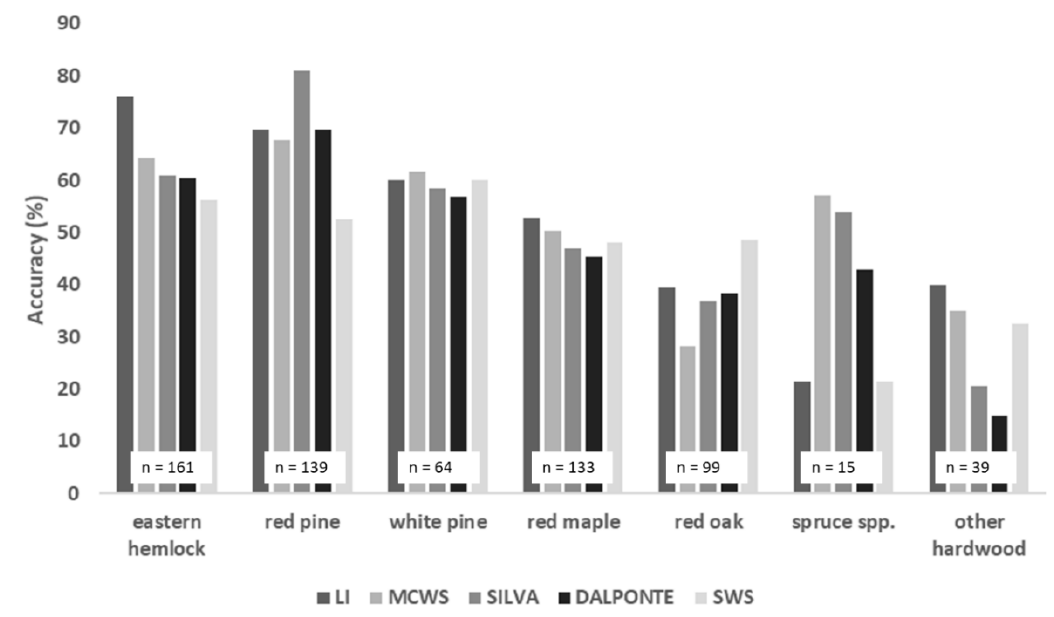
Figure 4. Automated crown delineation routines generally showed similar patterns of accuracy across the dominant species.